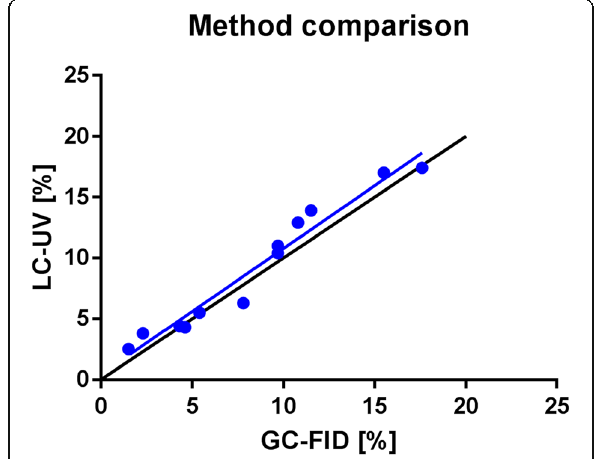
Fig. 6 Method comparison of overall THC/THCA content determination by GC-FID and